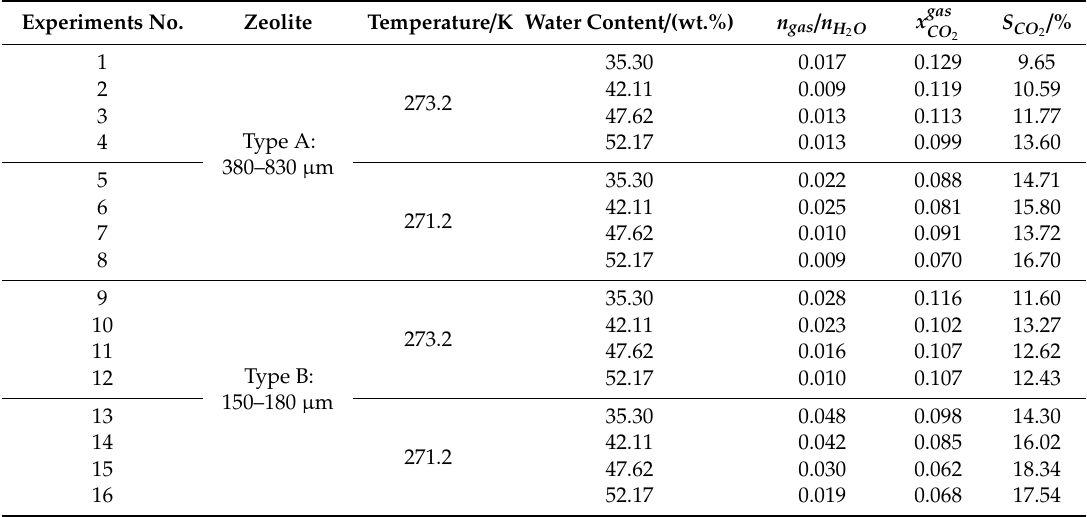
Table 2. Experimental conditions and results of hydrate based gas separation of CO 2 / N 2 with 5A zeolite. Experiments No. Zeolite Temperature / K Water Content /